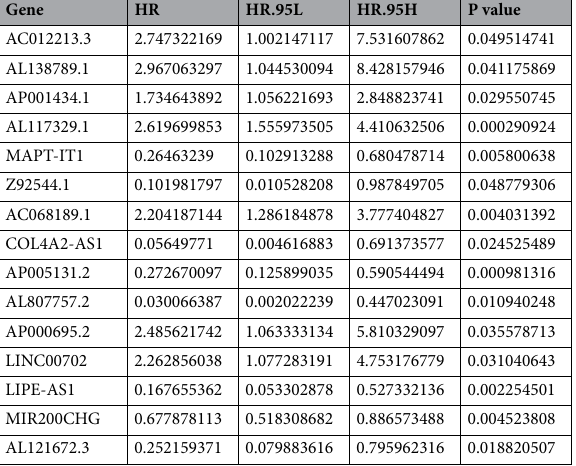
Table 3. Univariate analysis showing associations between androgen receptor signaling pathway-related lncRNA in BRCA. Unadjusted HRs are shown with 95% confidence